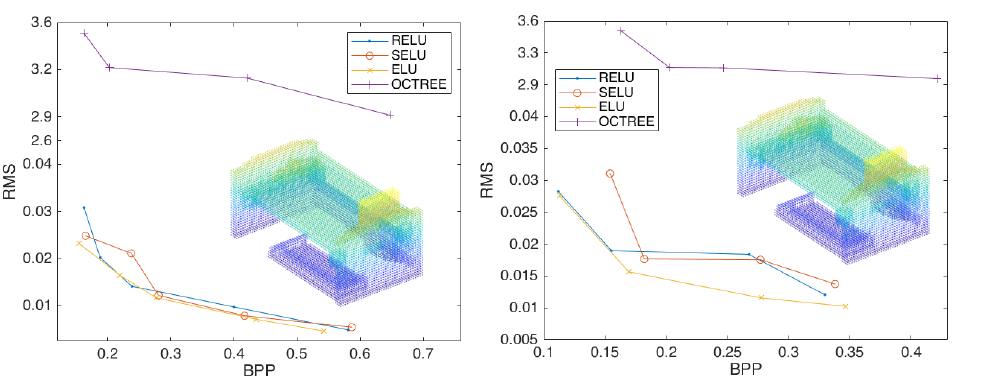
Figure 6. The compression performance of the scheme configured with two layers of convolution and three strides ( left ) and three layers of convolution and three strides ( right ), using the activation functions Relu , Selu , and Elu